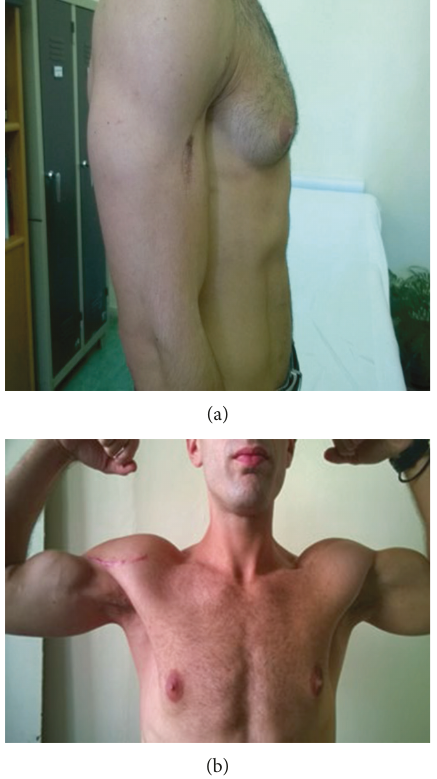
Figure 5: Postoperative images three years after the